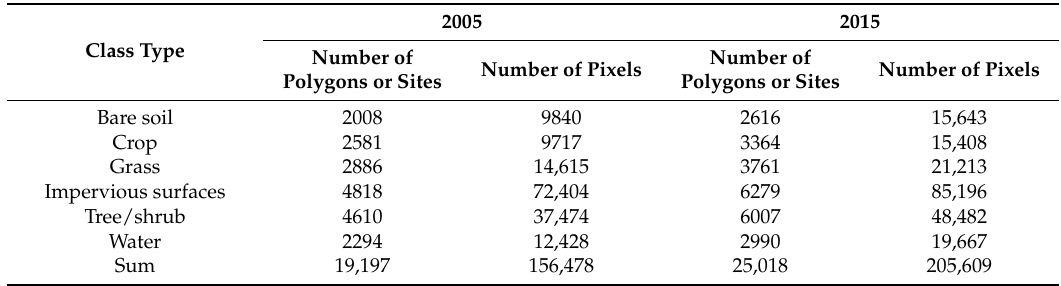
Table 1. The number of training samples for land cover